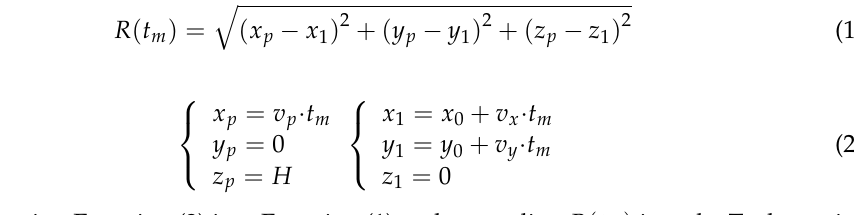
v along the x- p v v v , and x x y R is the slant range from 0 t represents the slow time series, m